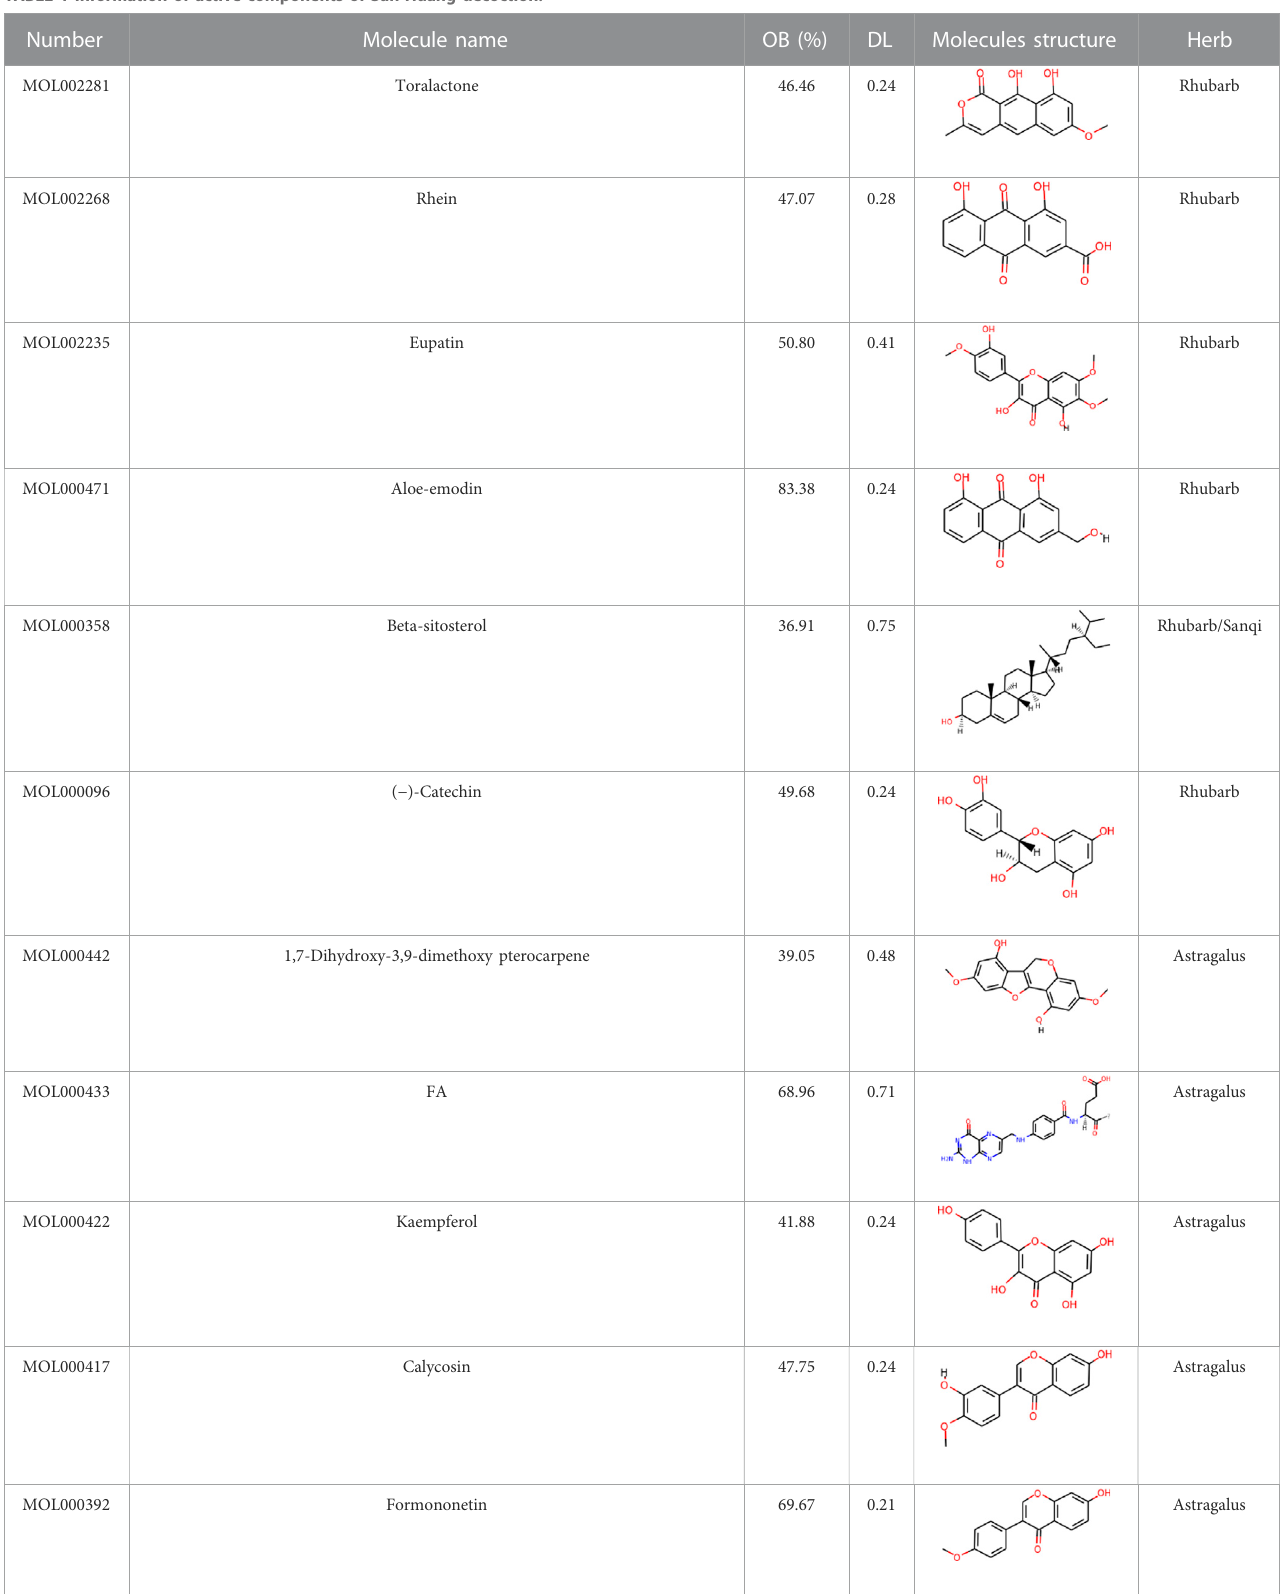
TABLE 1 Information of active components of San-Huang